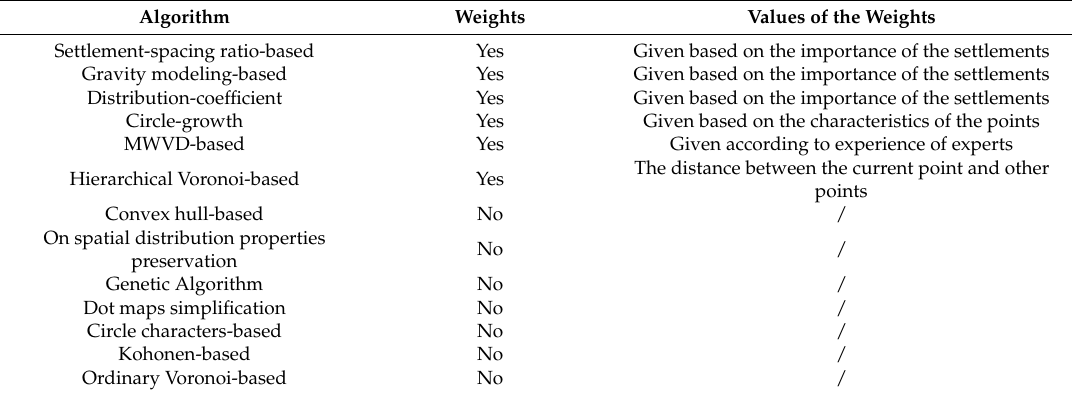
Table 1. Two types of algorithms for point cluster